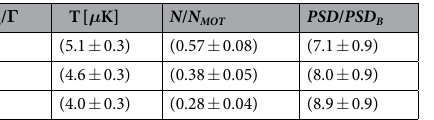
Figure 5. Raman detuning. Left: Temperature T and Right: normalized phase space density PSD / PSD B ( N / N MOT is shown in the inset) as a function of the Raman detuning δ R . In both graphs, we show three different datasets: Δ = 5 Γ (pink circles), Δ = 8 Γ (blue squares) and Δ = 12 Γ (green triangles). 22 22 22 Δ 22 / Γ